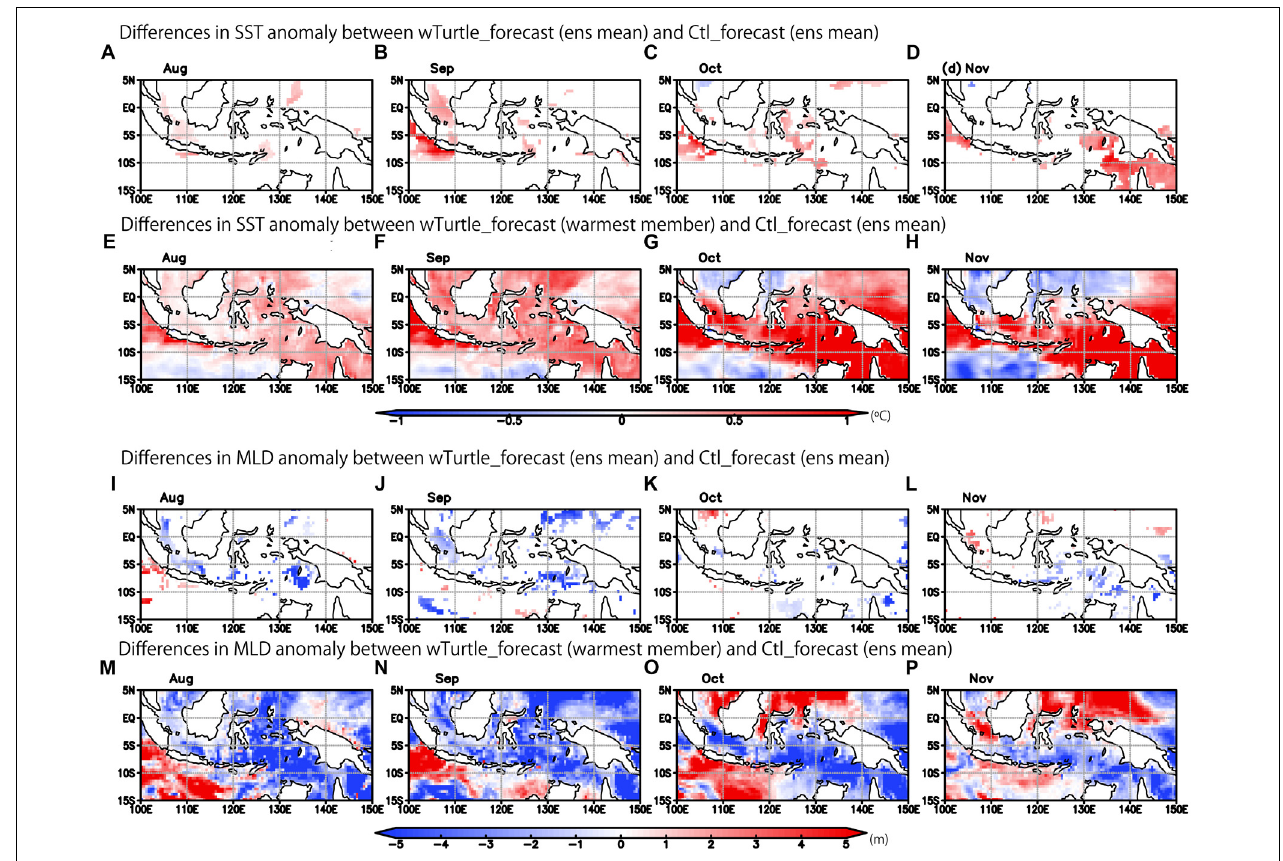
FIGURE 7 | Differences in SST anomalies between the wTurtle_forecast (ensemble mean) and the Ctl_forecast (ensemble mean) issued on August 1, 2017, for (A) August, (B) September, (C) October, and (D) November 2017 ( ◦ C). The statistically significant difference beyond the 90% confidence levels on paired t -test are shown by shaded parts. Differences in SST anomalies between the warmest ensemble members of the wTurtle_forecast (shown in Figure 6 ) and the Ctl_forecast (ensemble mean) issued on August 1, 2017, for (E) August, (F) September, (G) October, and (H) November 2017 ( ◦ C). (I–L) The same as (A–D) but for the mixed layer depth (m). (M–P) The same as (E–H) but for the mixed layer depth